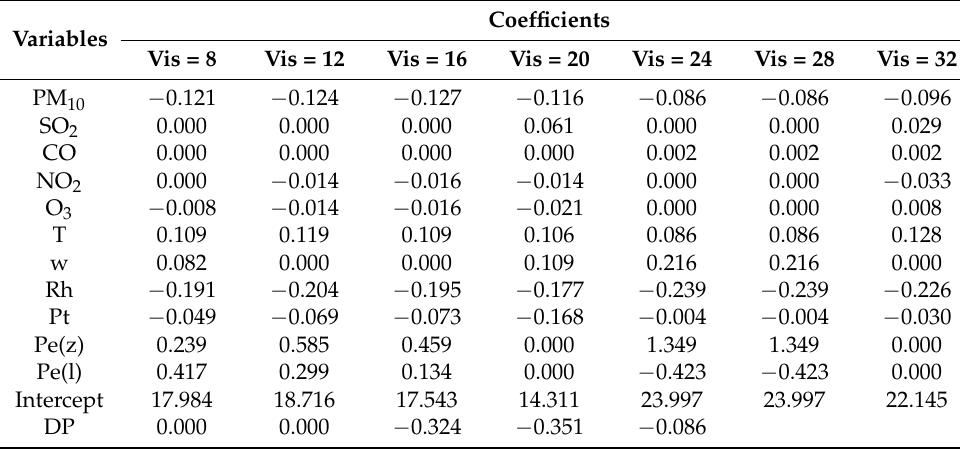
Table A1. Results of computing α i coefficients in logit models.